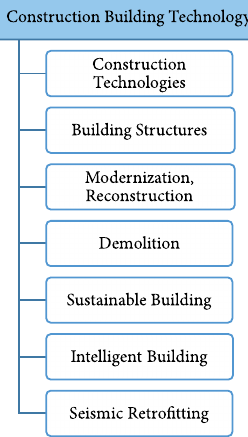
Fig. 3. Research domains in